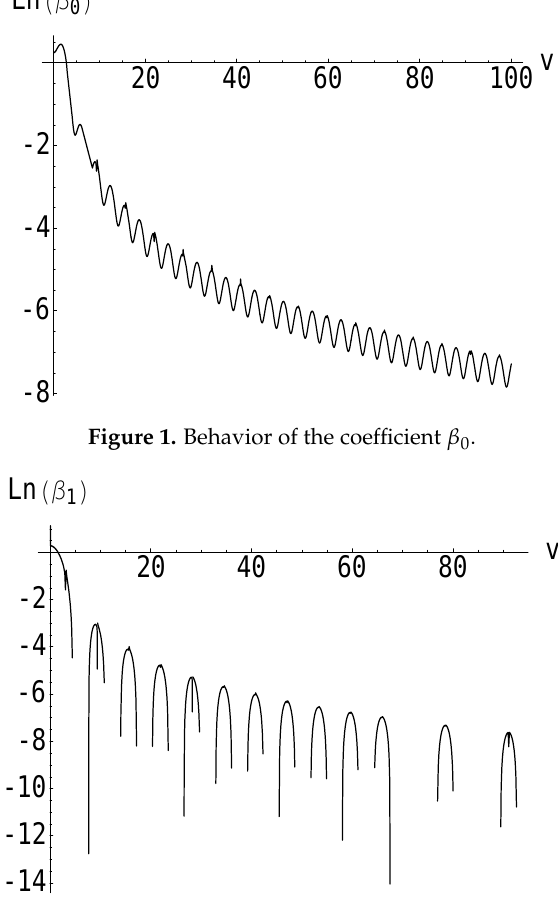
Figure 2. Behavior of the coefficient β 1